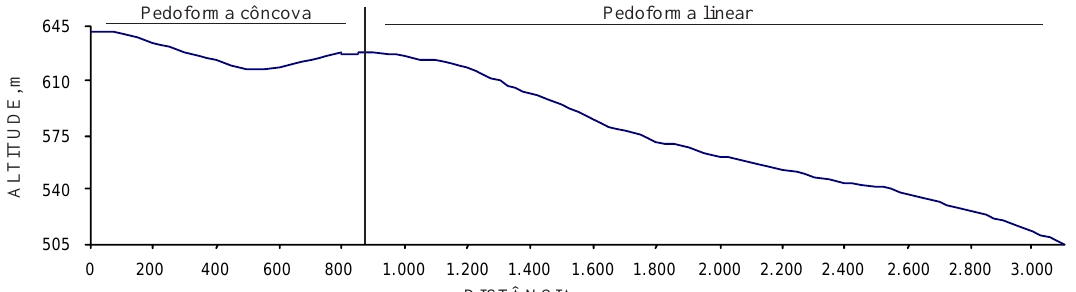
Figura 1. Perfil altimétrico, abrangendo as pedoformas, côncava e linear, da área em estudo, segundo a classificação de Troeh